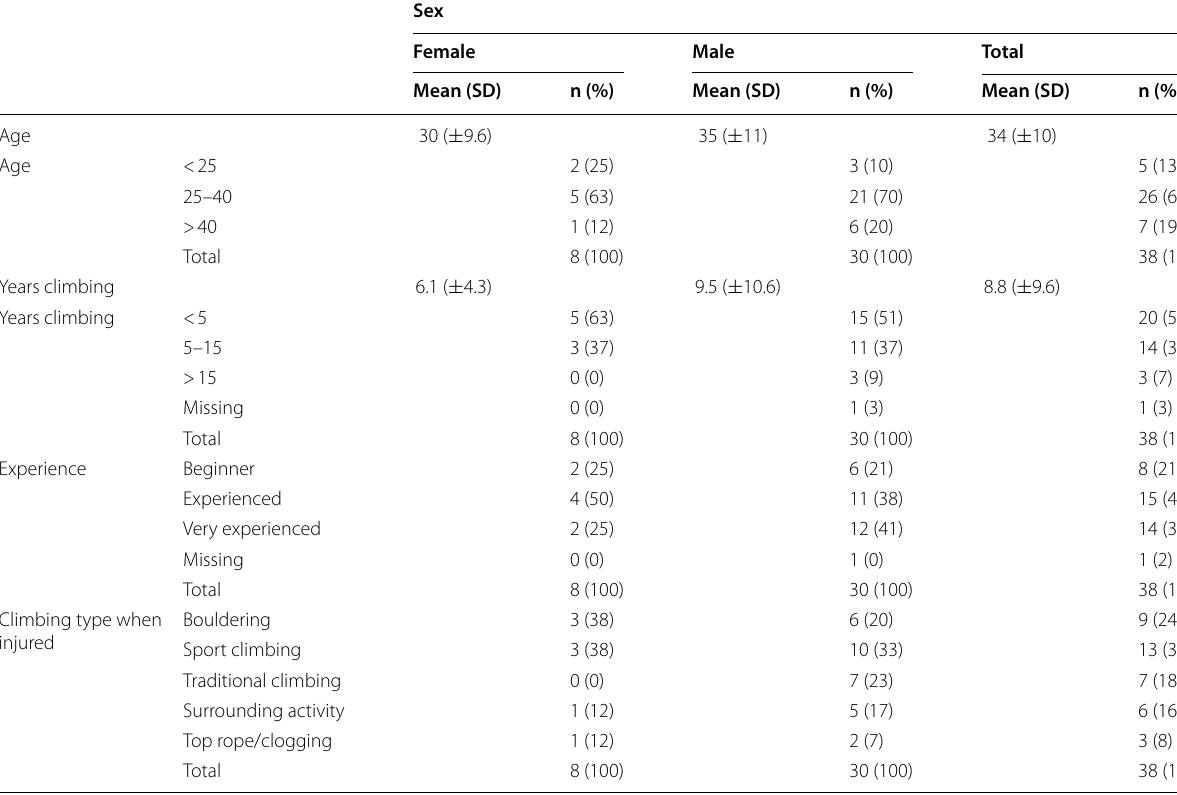
Table 1 Demographics of included